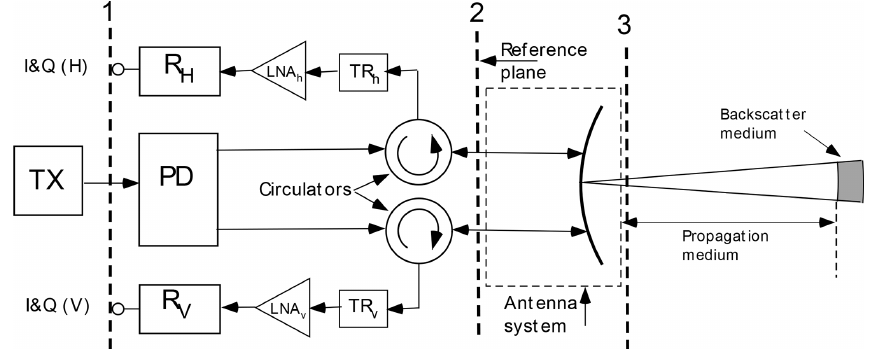
Figure 1. A general block diagram of the DWD radar systems. TX refers to the transmitter; PD is the power divider, and TR h , v are the TR limiters in the H and V receive paths. I&Q denotes the plane where the received analog signal at the intermediate frequency (IF) is digitized in the IFD (intermediate frequency